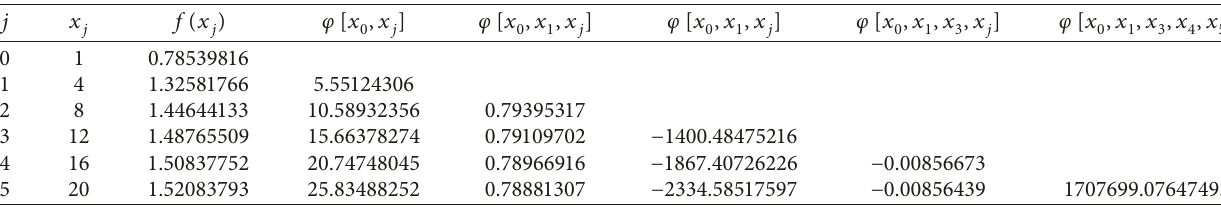
Table 1: Table of inverse